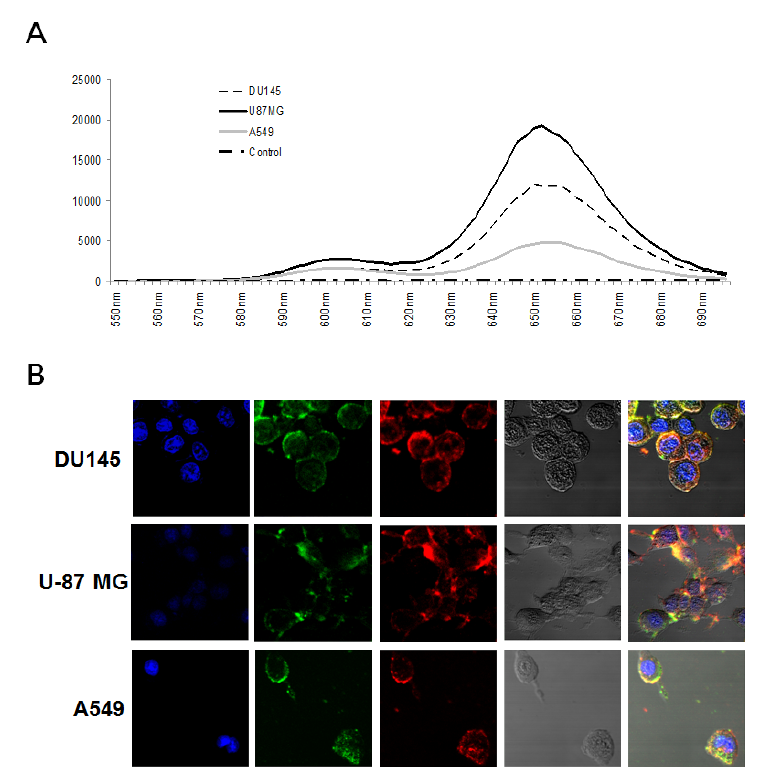
Figure 5. Simultaneous imaging of two cancer biomarkers in three different cancer cell lines. ( A ) Fluorescence emission spectra of a QD-TTA-1 and QD-AS1411 mixture in three cancer cell lines. DU145 (dotted black line), U-87 MG (solid black line), A549 (gray line), and baseline (dash-dotted line); excitation: 480 nm, scanning wavelength: 500–800 nm, with a bandwidth of 10 nm; ( B ) Confocal microscope images of cells incubated with two types of QD-aptamer conjugates. Column 1: DAPI (blue: 420–480 nm); column 2: QD-TTA-1 (green: 560–615 nm); column 3: QD-AS1411 (red: 647–690 nm); column 4: bright field; column 5: merged fluorescence image of DAPI and bright field and QD-aptamer